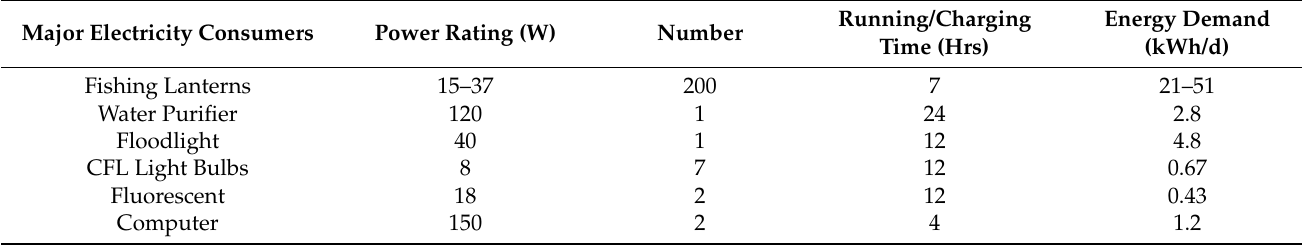
Table 3. Detailed information on major electricity consumers at Mbita WeTu Hub [39].